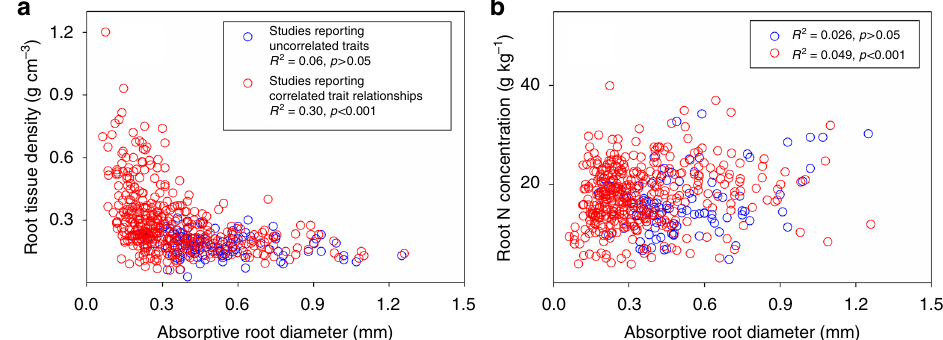
Fig. 4 Root trait relationships for different data sources. Relationships between absorptive root diameter and root tissue density (RTD) ( a ) and root N concentration (RN) ( b ) in different sets of studies on woody species. Studies reporting correlated trait relationships (i.e., negative RTD- root diameter and positive RN-root diameter correlations) are indicated by red circles, and studies reporting uncorrelated trait relationships are indicated by blue circles. The insets show the fi tness of the allometry-based nonlinear